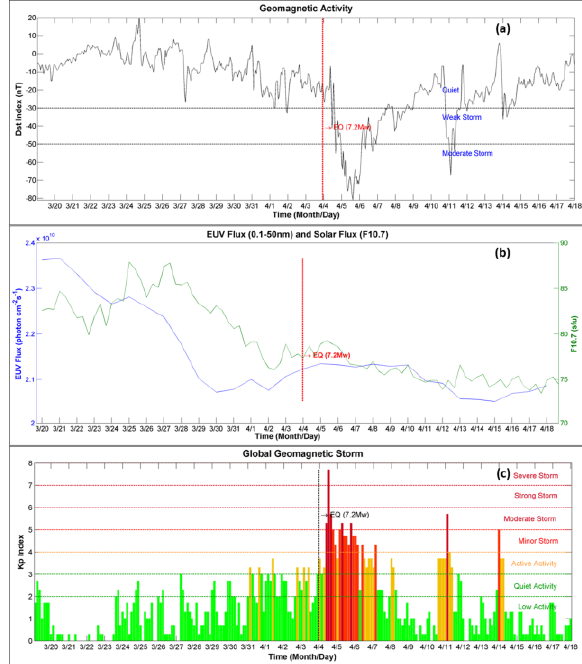
Figure 5. Dst, EUV, F10.7, and Kp indices during the period from March 20 to April 18,